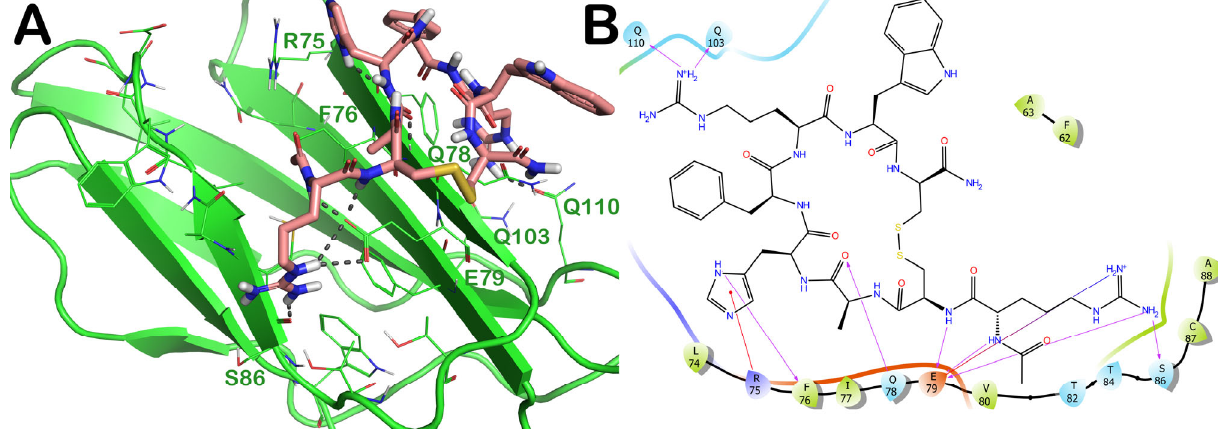
Figure 9. ( A ) Docking output of the drug PID 11993702 (setmelanotide) (light pink sticks) within the surface of the irisin monomer (PDB ID 4LSD, green cartoon) involved in the dimerization process. The key interacting residues are represented by lines. The H bonds are depicted as do tt ed lines.